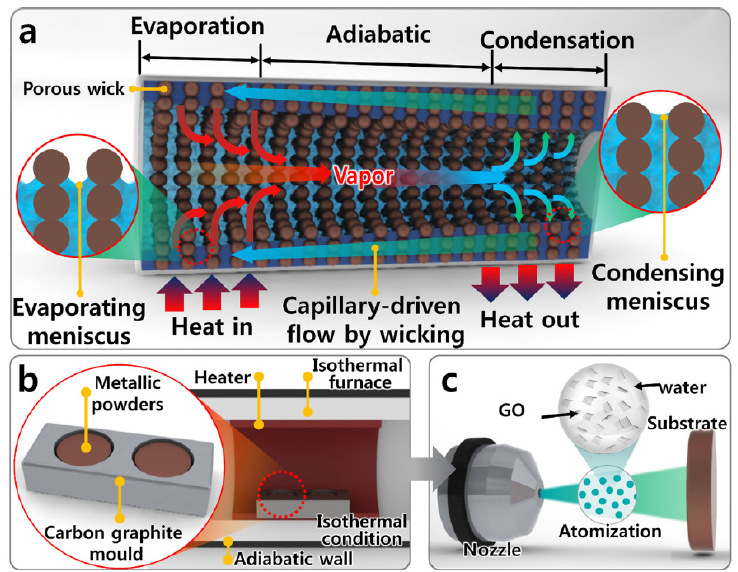
Figure 7. ( a ) Schematic of a heat pipe with a two-phase flow loop, ( b ) sinter of non-uniform copper particles at 600 °C using an isothermal furnace under a vacuum, and ( c ) suspension of graphene oxides in distilled water and the process of spraying this solution on copper wicks [94].